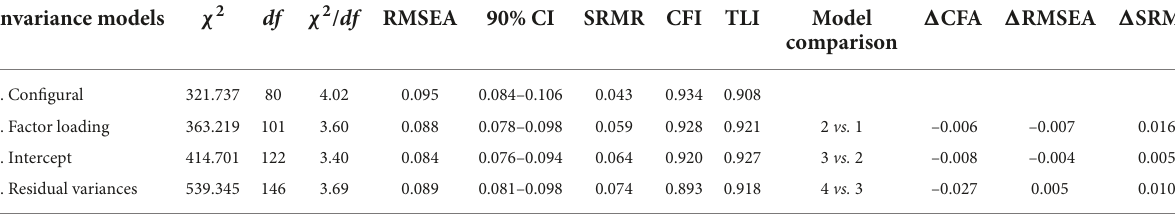
TABLE 5 Fitting results of invariance tests across grades. Invariance